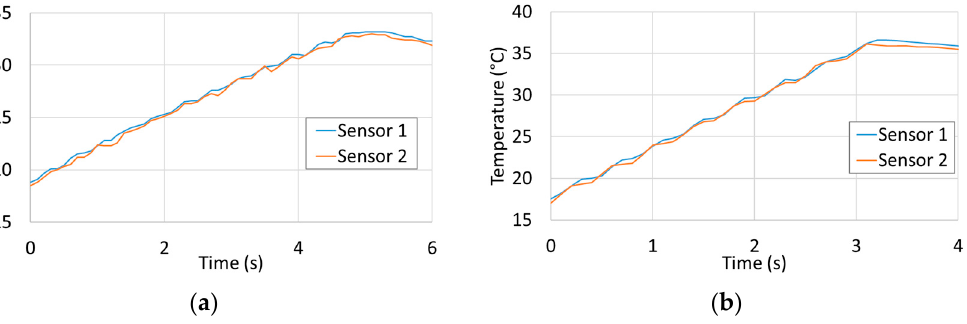
Figure 18. Temperature measurements for S690, UHCF specimen: ( a ) Maximum stress = 220 MPa, t on = 0.2 s, t off = 0.2 s, 12 pulses; ( b ) Maximum stress = 390 MPa, t on = 0.2 s, t off = 0.2 s, 8 pulses.